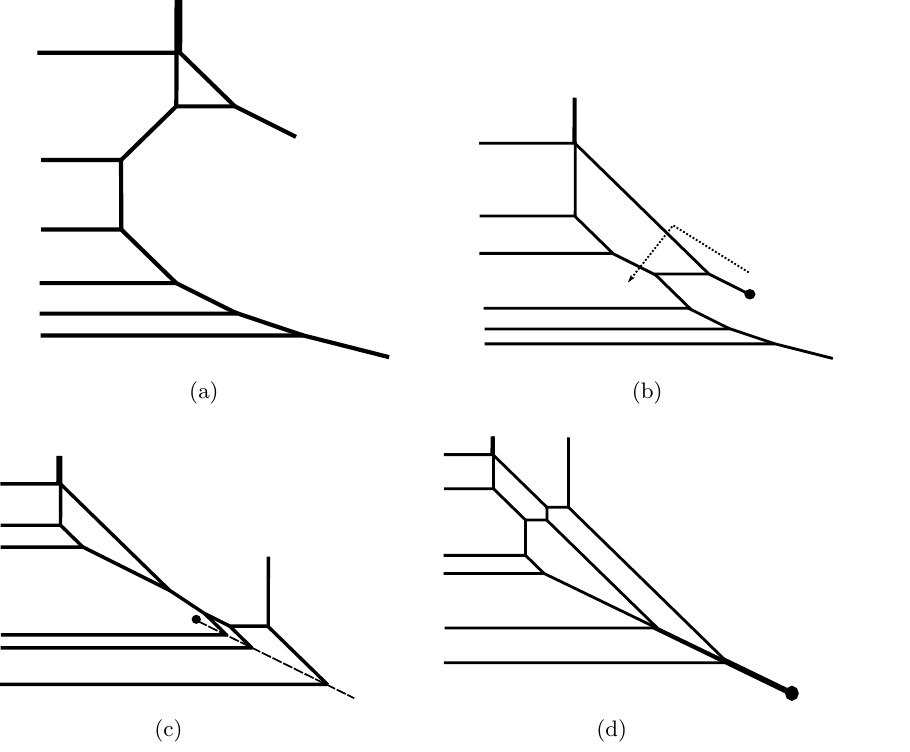
Figure 28 . (a) A diagram involving the rank-2 antisymmetric matter for an SU(6) gauge theory. (b) Performing (cid:13)op transitions to the diagram in (cid:12)gure 28(a) and then moving the (2 ; (cid:0) 1) 7-brane in the direction given by the arrow. (c) The diagram obtained after moving the (2 ; (cid:0) 1) 7-brane. (d) The diagram obtained after performing (cid:13)op transitions to the diagram in (cid:12)gure